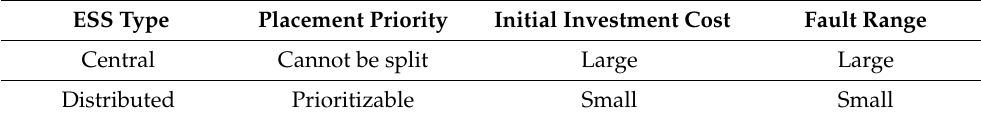
Table 1. Comparison between central and distributed